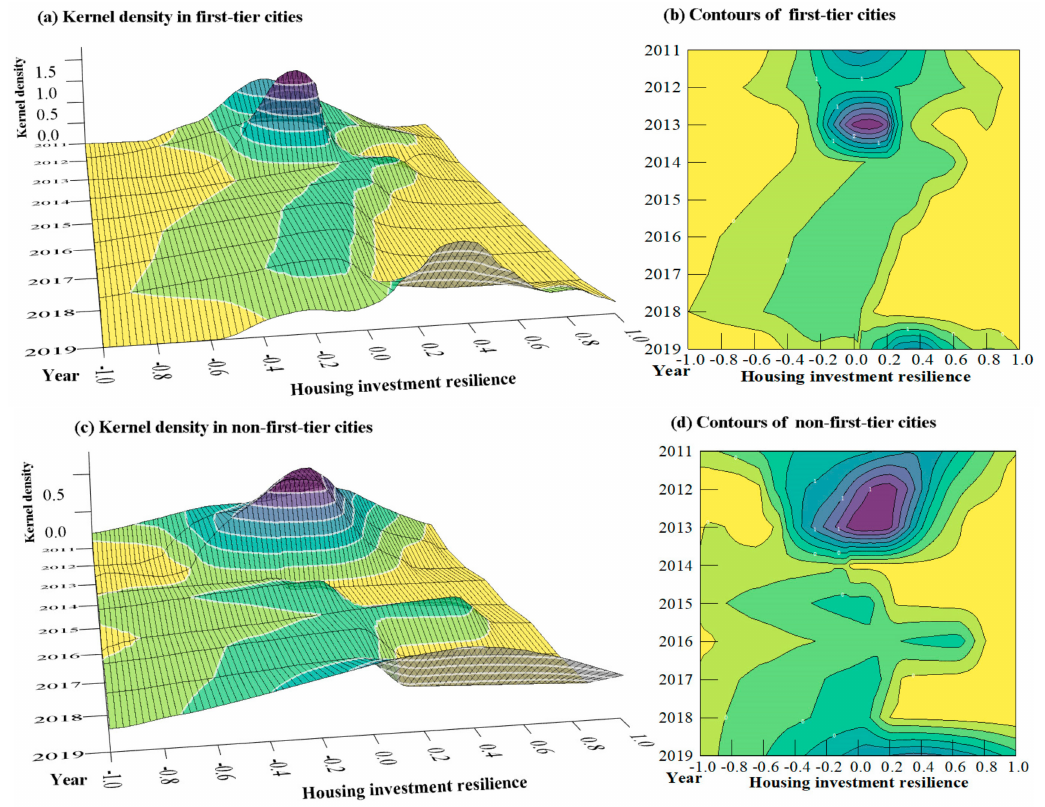
Figure 5. Evolution of housing investment resilience in first-tier and non-first-tier cities, 2011–2019. Note: ( a ) Housing investment resilience Kernel density in first-tier cities; ( b ) Housing investment resilience contours of first-tier cities; ( c ) Housing investment resilience Kernel density in non-first-tier cities; ( d ) Housing investment resilience contours of non-first-tier